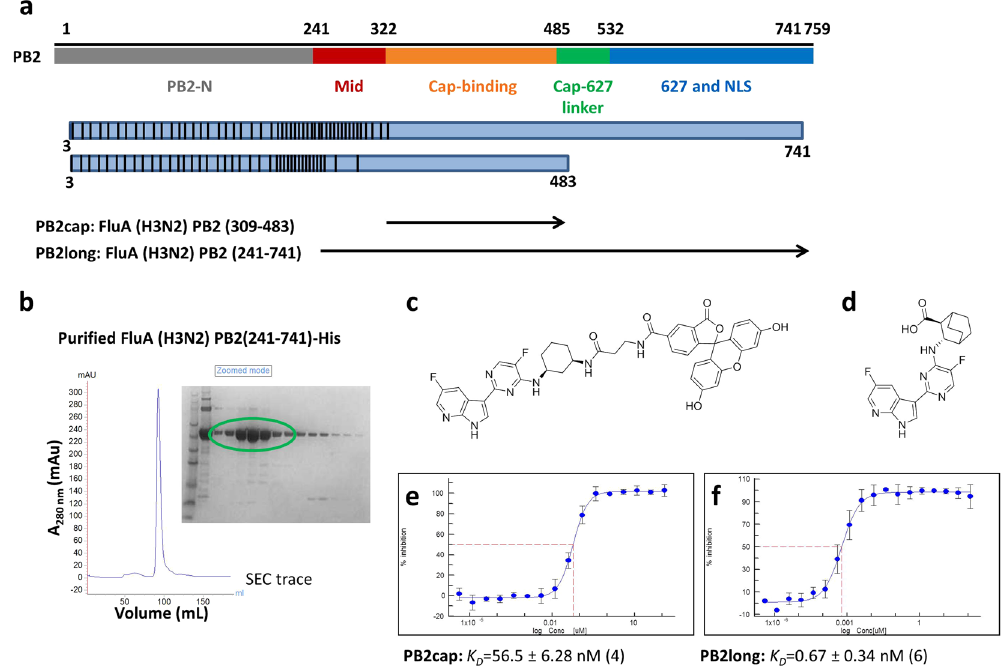
Figure 1. Protein engineering and FP binding properties of H3N2 PB2long. ( a ) Schematic representation of the high-throughput cloning of PB2. The black vertical line represents the starting position of each truncation, ranging from amino acid 3 to 318. The C-terminal amino acids are indicated at the end of each blue rectangle box. The black arrows represent the final constructs that were used in this study. ( b ) The elution profile of H3N2 PB2long-His purified by size-exclusion chromatography (SEC) and Coomassie blue-stained SDS-PAGE of the protein. Fluorescein (FAM)-labelled VX-787 analog ( c ) was incubated with increasing amounts of PB2 protein. The affinity of VX-787 ( d ) towards FluA PB2cap and PB2long measured by fluorescence polarization. Error bars, standard deviation from four or six independent measurements for PB2cap ( e ) and PB2long ( f ),